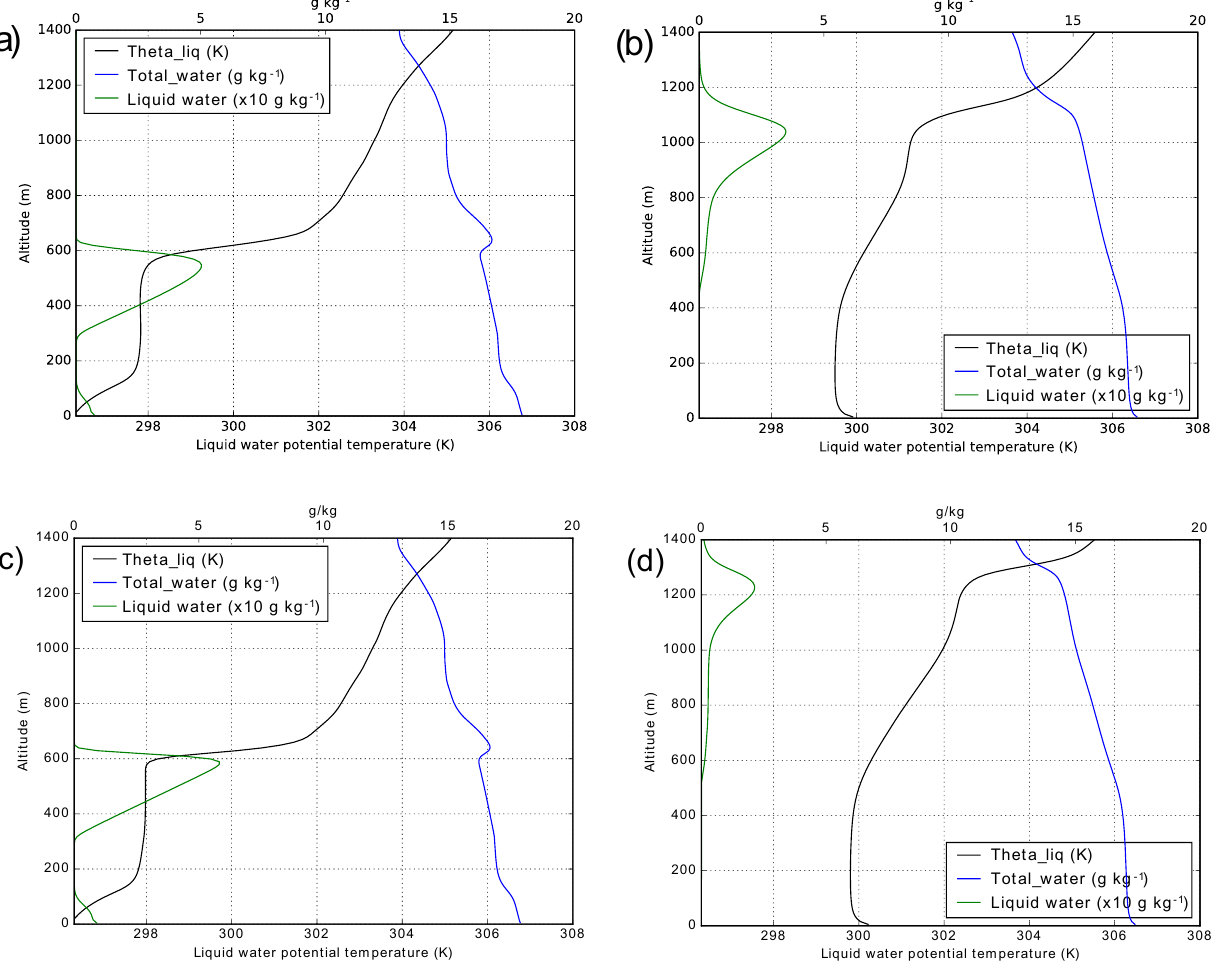
Figure 6. Vertical profiles of liquid water potential temperature (K; black lines), total water mass mixing ratio (gkg − 1 ; blue lines), and liquid water mass mixing ratio ( × 10gkg − 1 ; green lines) diagnosed at (a) 05:30UTC and (b) 11:00UTC from the CASIM_NO_PROC experiment. Equivalent plots for CASIM_NO_SED are shown in (c) and (d) respectively.